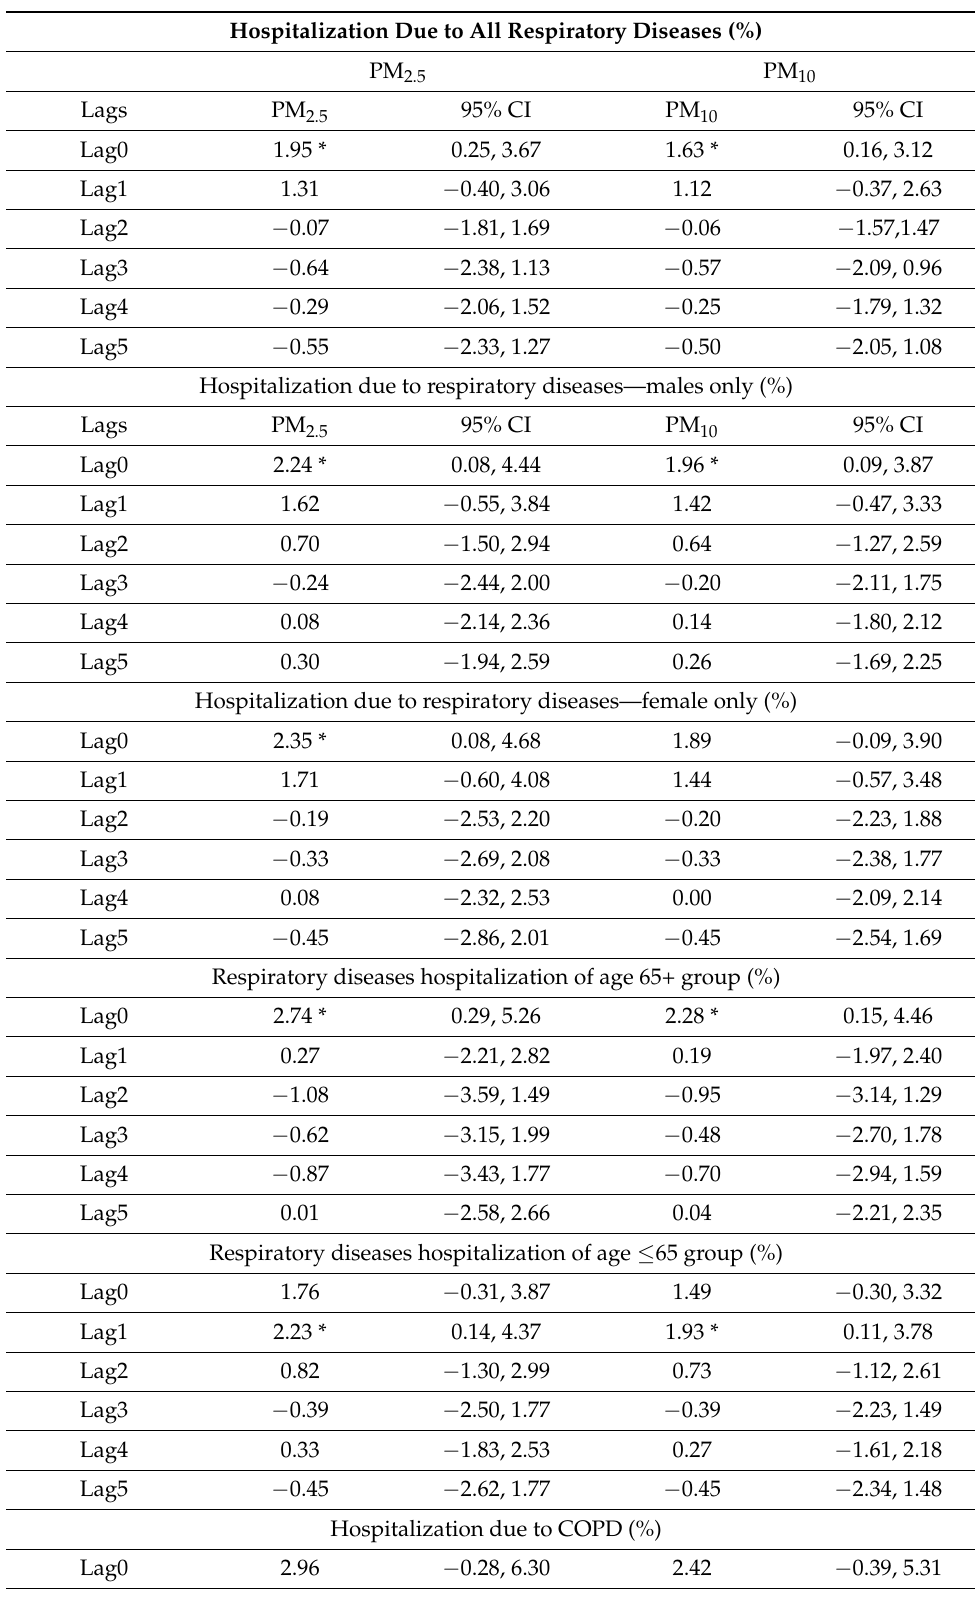
Table 2. The percent change for respiratory disease hospitalizations associated with short-term 10 µ g/m 3 increases in particulate matter air pollutant